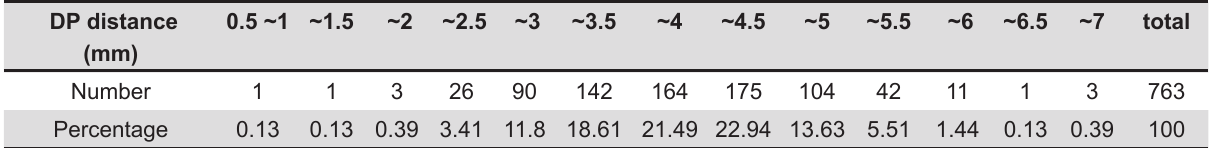
Table 3- DP distance (the distance between the palatal and the distobuccal root canal orifice) DP distance